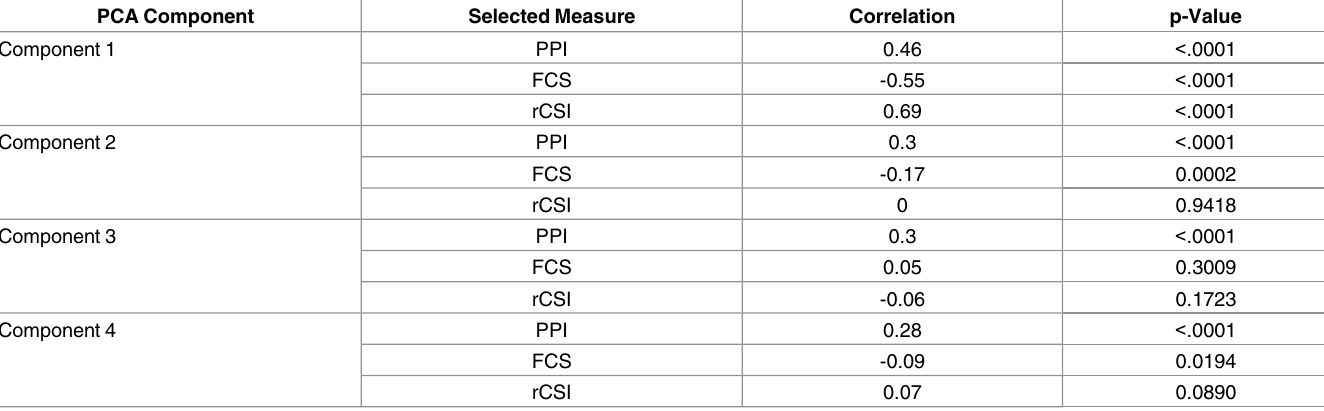
Table 4. Correlations of component scores with selected measures.